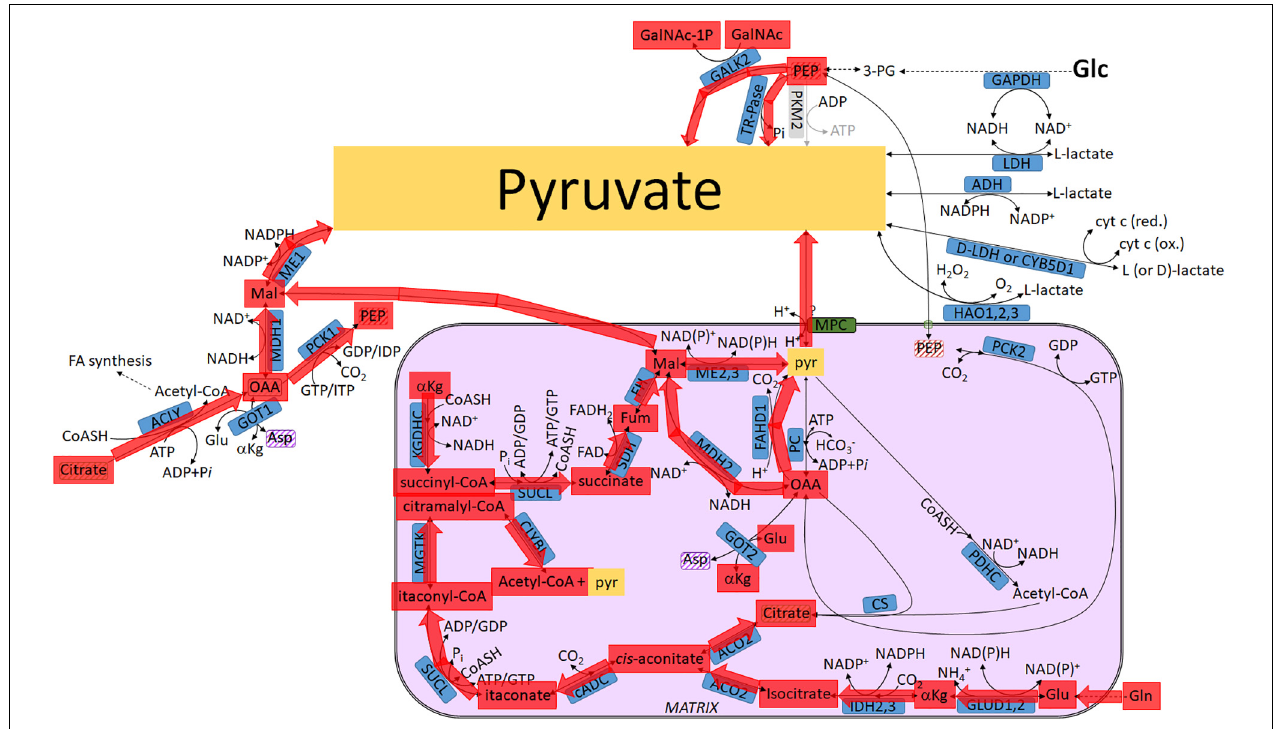
FIGURE 7 | Pathways leading to pyruvate commencing from glutamine (glutaminolysis), highlighted in red. For abbreviations, see Table 1